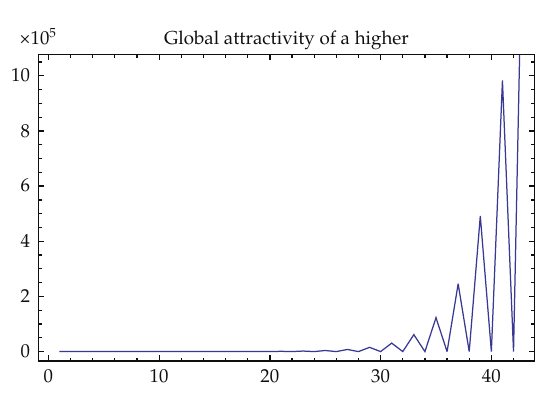
Figure 3: The di ff erence equation y n (cid:3) 1 (cid:4) 2 y n − 1 / (cid:5) 1 − y n y n − 2 (cid:6) .